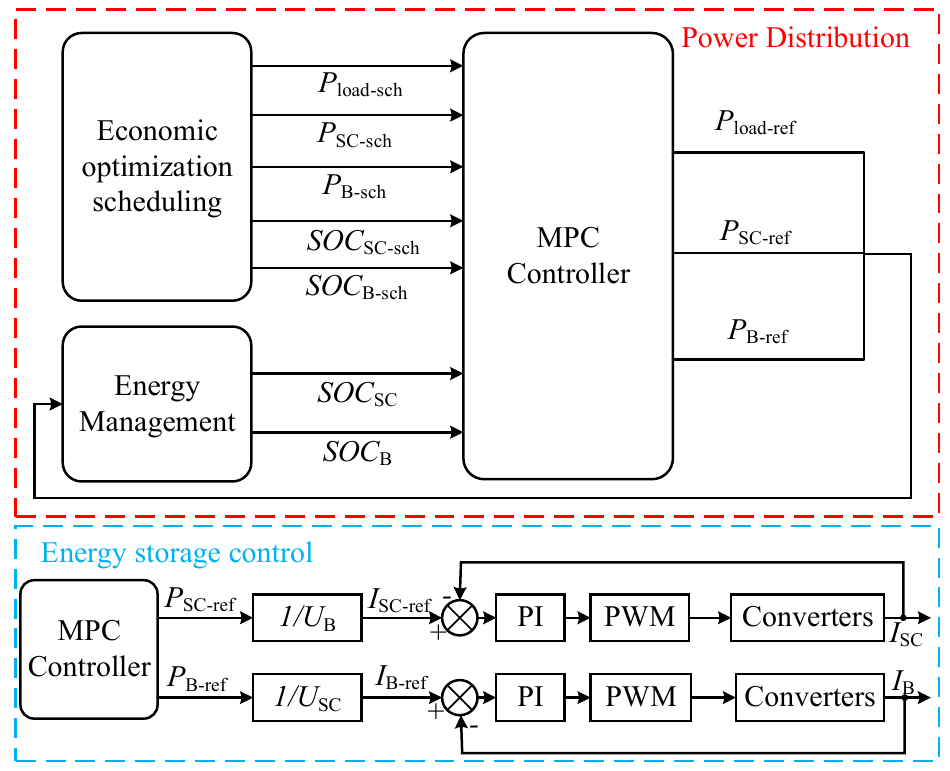
Figure 36. Block diagram of energy storage system model prediction.